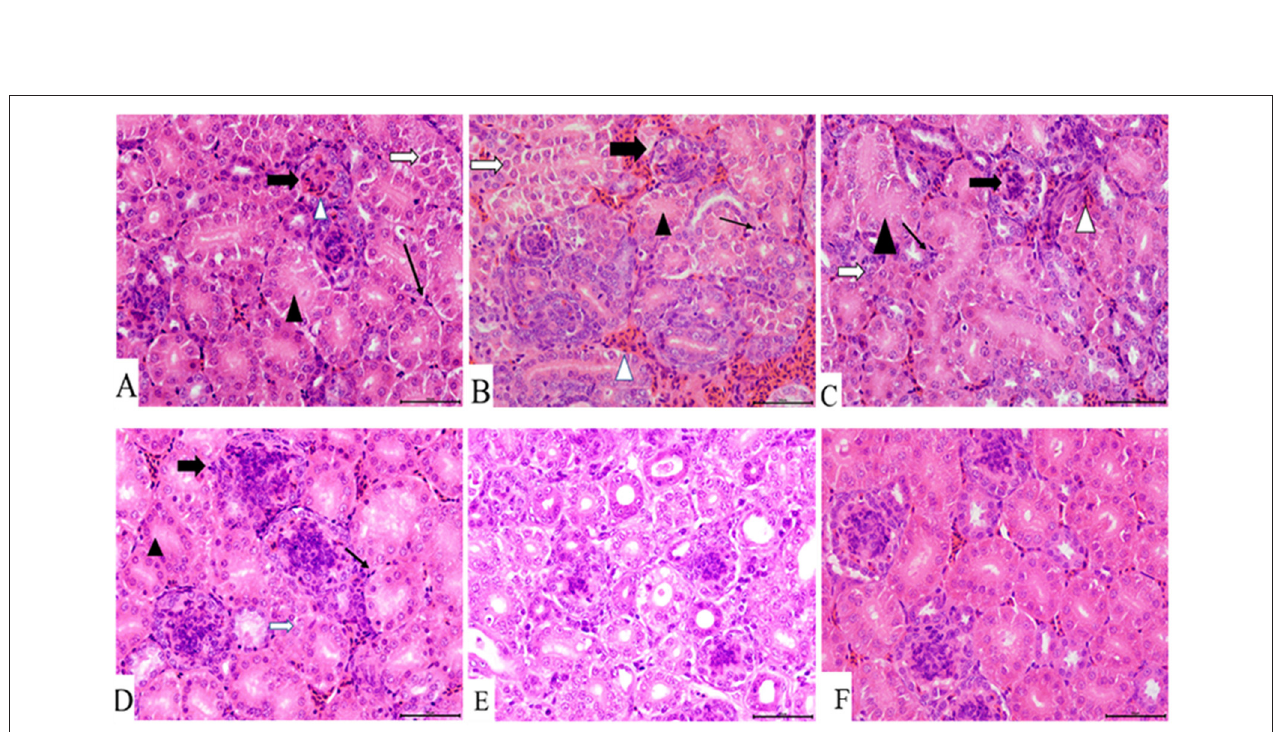
FIGURE 4 | Kidney histopathology at 7 dpi. (A) IBV/H9N2 group, (B) IBV + H9N2 group, (C) H9N2/IBV group, (D) IBV group, (E) H9N2 group, and (F) control group. Black triangles donate absence of the renal tubular lumen. White arrows donate degeneration of the renal tubular epithelial cells. Black lined arrows point to the exudation of monocytes. Solid black arrows represent the glomerulus enlargement and the absence of the renal capsule cavity. Magnification 400 × , scalebar 50 µ M. IBV, infectious bronchitis virus.